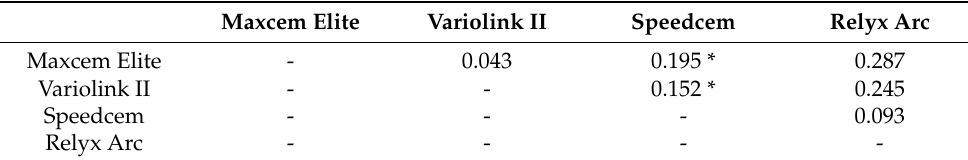
Table 5. Multiple comparison with polymerization efficacy as the dependent